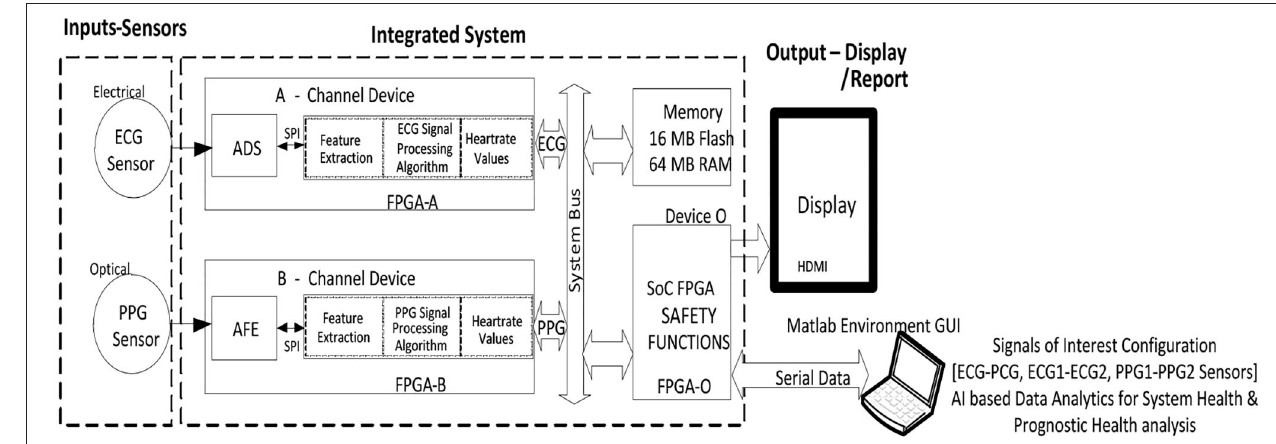
FIGURE 4 | 2oo2 fault-tolerant cardiac health monitoring system block diagram.